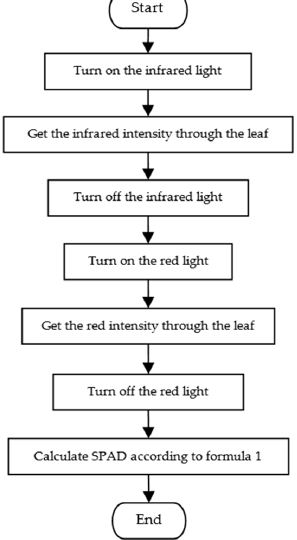
Figure 4. Program flowchart of Chlorophyll measurement module.